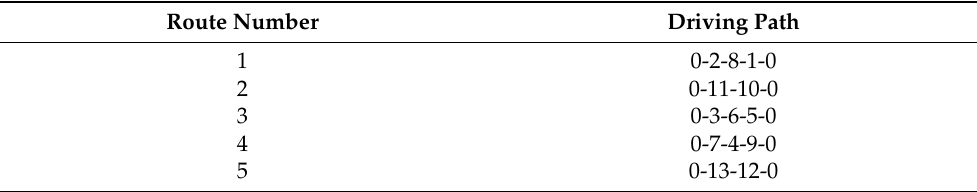
Table 9. Optimized distribution path table.